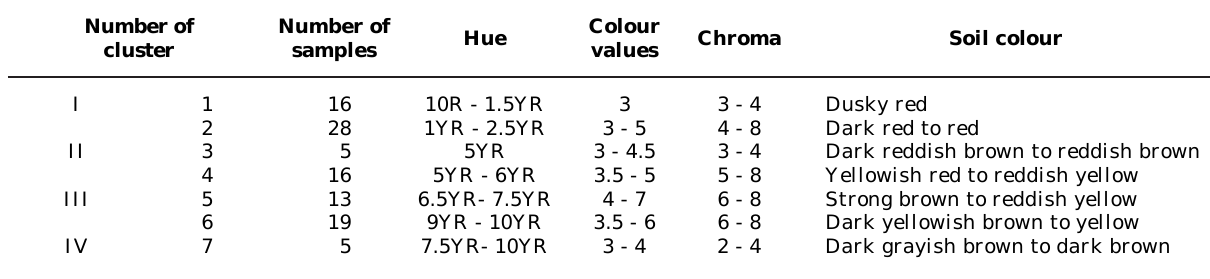
Table 4. Clusters of Ferralsols and related soils based on their colour hues, values and